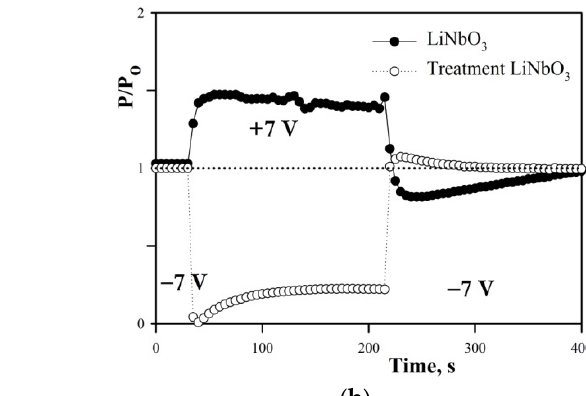
Figure 4. Mechanism of short-term DC-drift measurements.